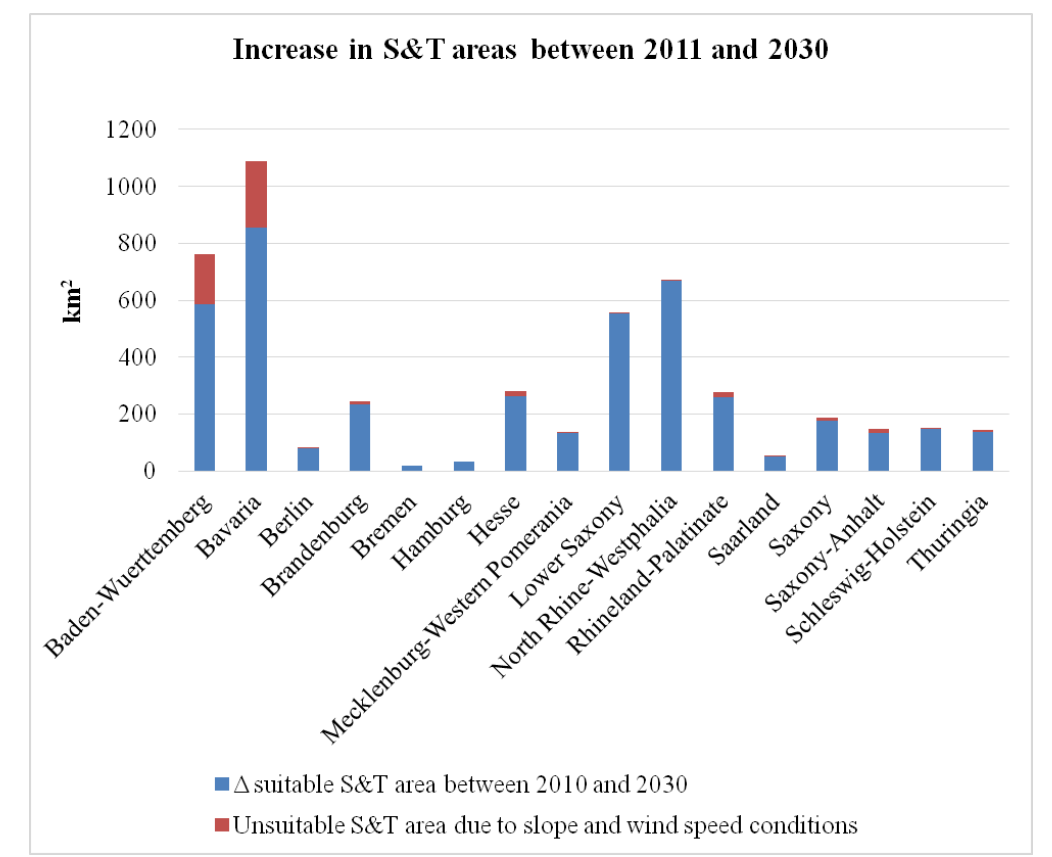
Figure 2. Increase of suitable and unsuitable settlement & traffic (S&T) areas between 2011 and